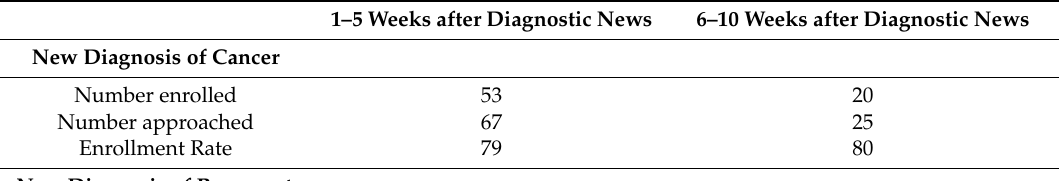
Table 3. Enrollment Rates by time since hearing diagnostic